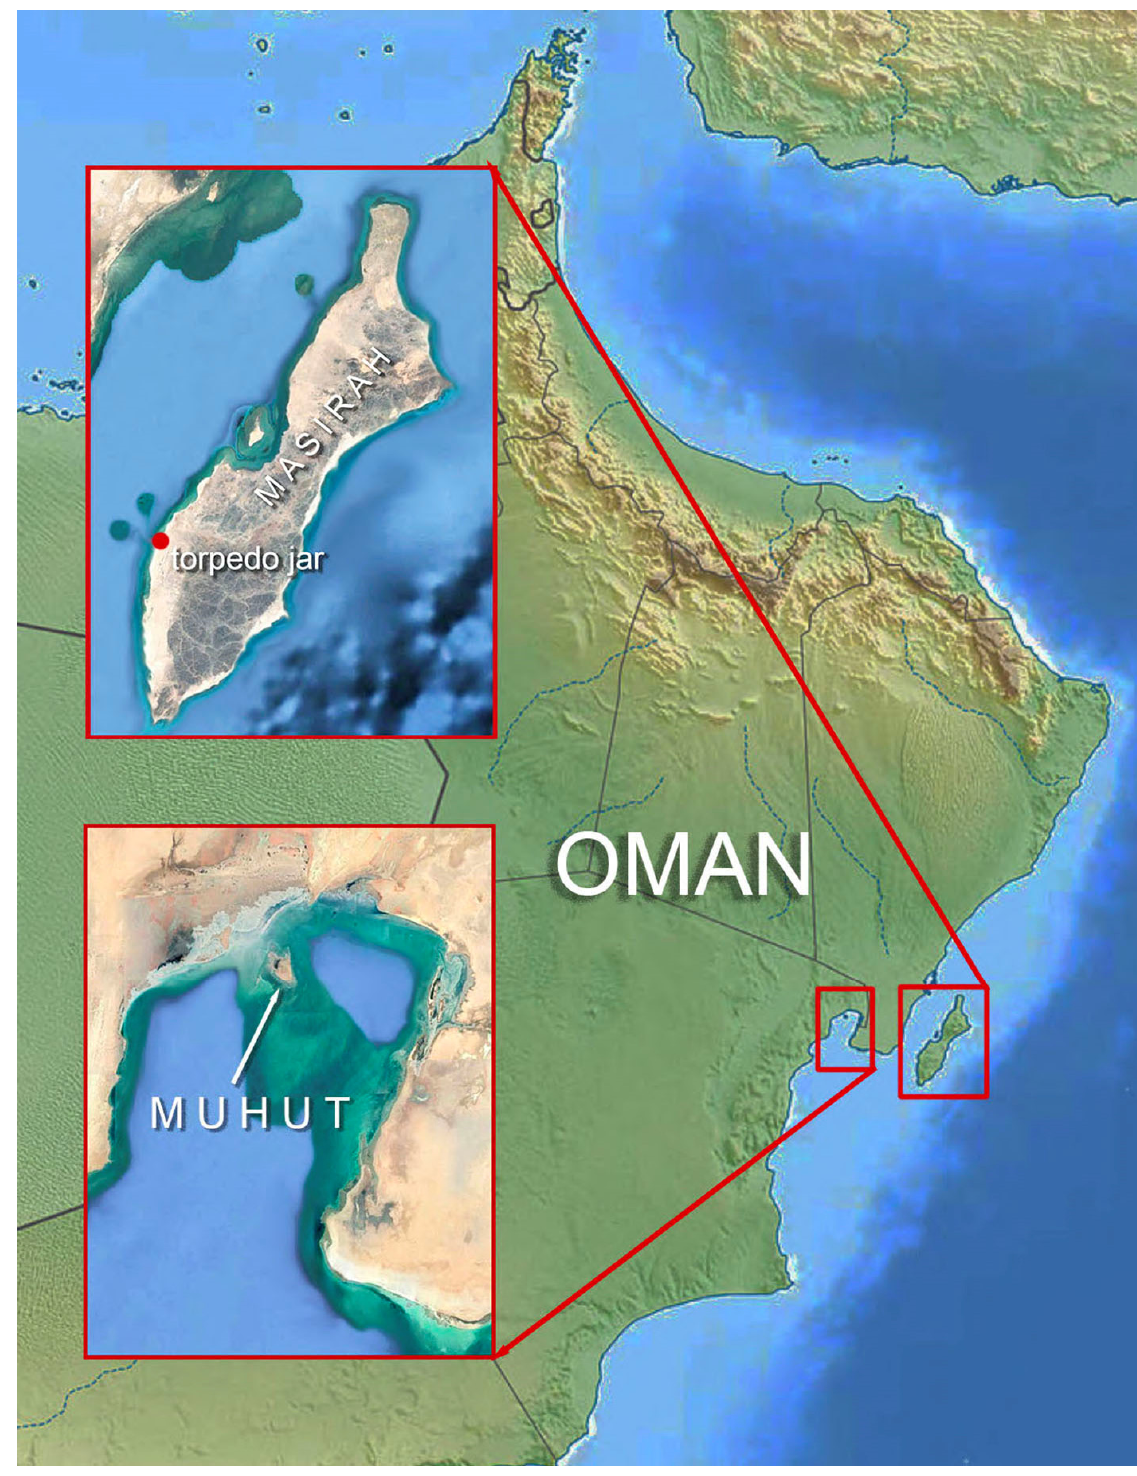
Figure 1. Location of the Muhut amphorae and of the Masirah torpedo jars.